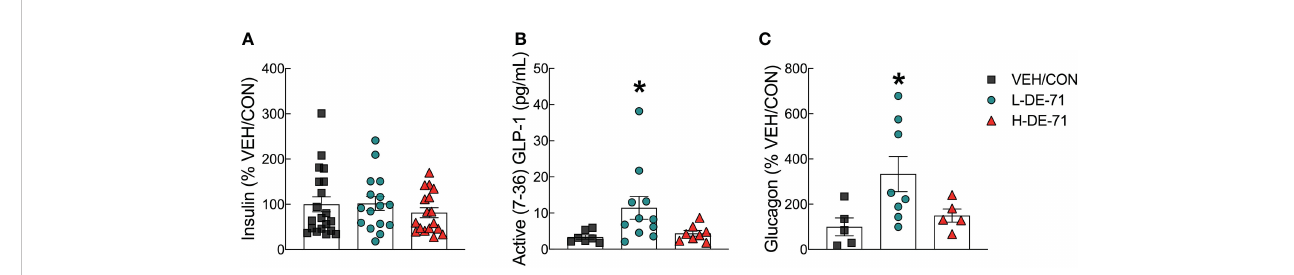
FIGURE 5 Endocrine-disrupting effects of DE-71 on glucoregulatory hormones in male mice. Blood collected at sacri fi ce was assayed for plasma levels of (A) insulin (B) GLP-1 and (C) glucagon using speci fi c commercial enzyme-linked immunoassay kits. *indicates signi fi cantly different from corresponding VEH/CON (* p <0.05). Bars and error bars represent values expressed as mean ± s.e.m. n =16-20/group for insulin, n =7-11/group for GLP-1, n =5-8/group for